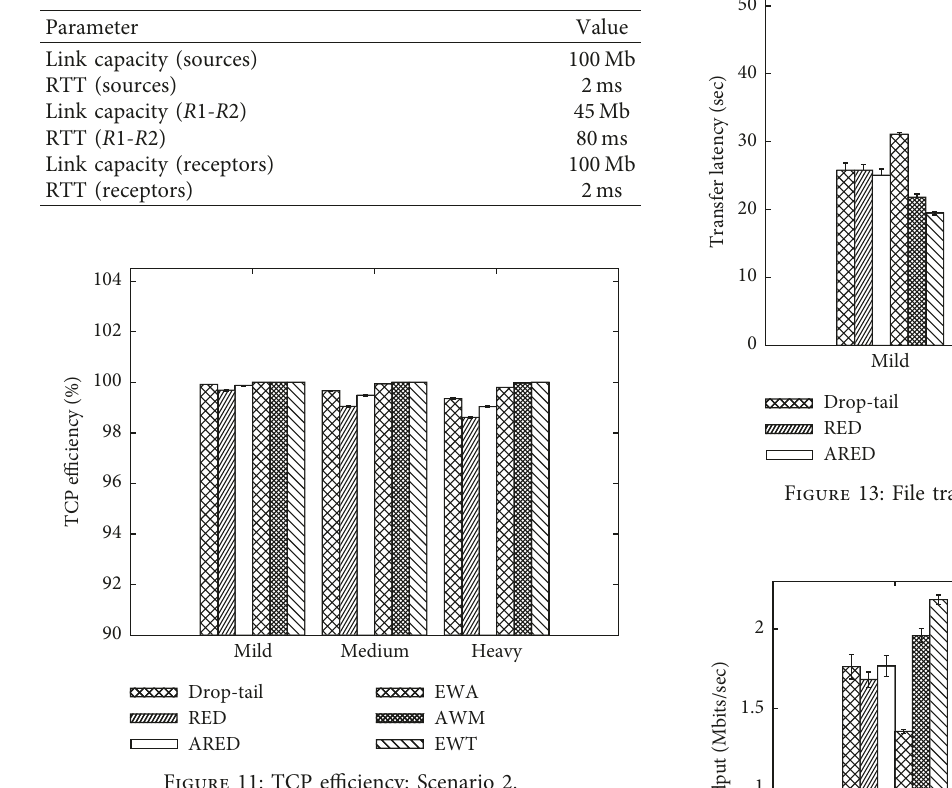
Figure 11: TCP efficiency: Scenario 2.